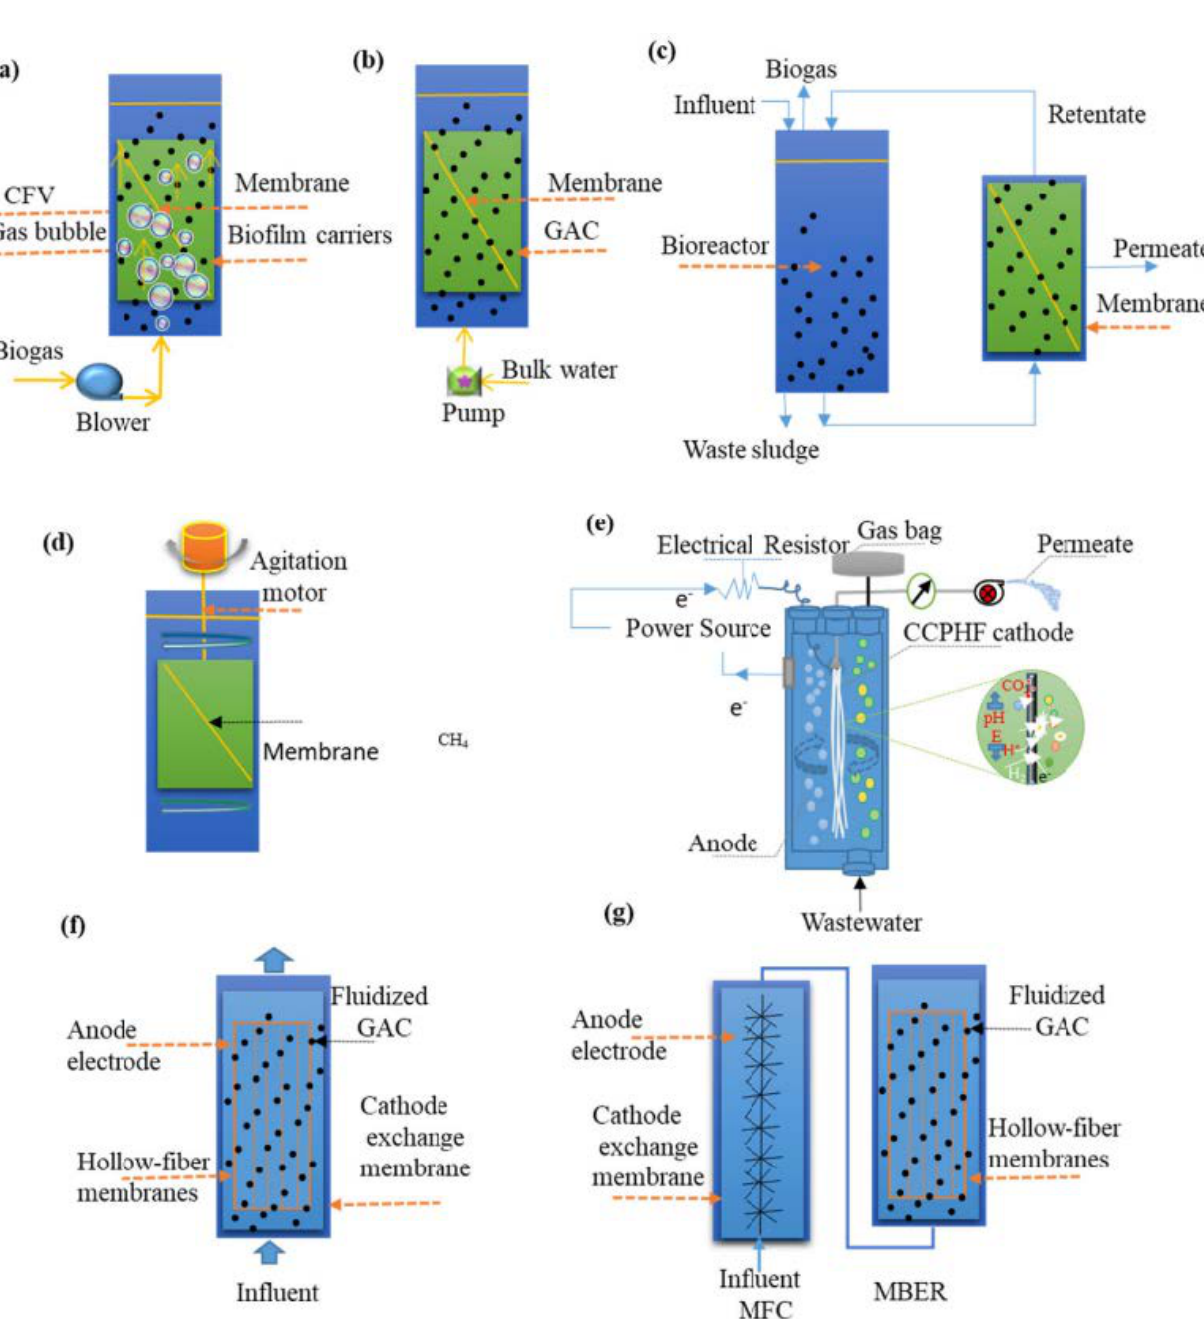
Figure 8. Configurations of AnMBR: ( a ) Biogas-particle sparging; ( b ) Liquid recirculation particle-sparging; ( c ) Anaerobic crossflow-particle sparging MBR; ( d ) Anaerobic rotating MBR ( e ) Anaerobic electrochemical membrane bioreactor; ( f ) Individual fluidized MBER; ( g ) Hybrid MFC-MBER system [55].